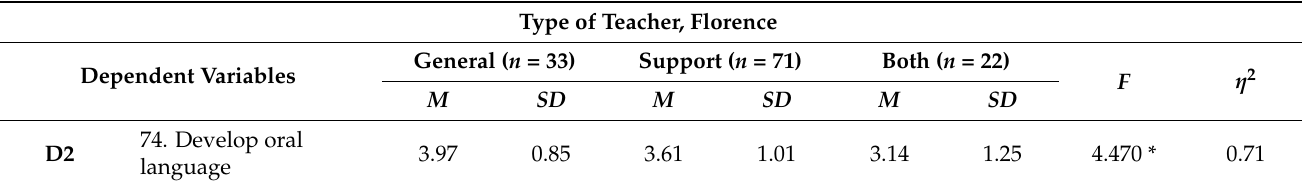
Table 13. Significant differences in the benefits and uses of apps as a function of the teaching position of the educators from Florence.